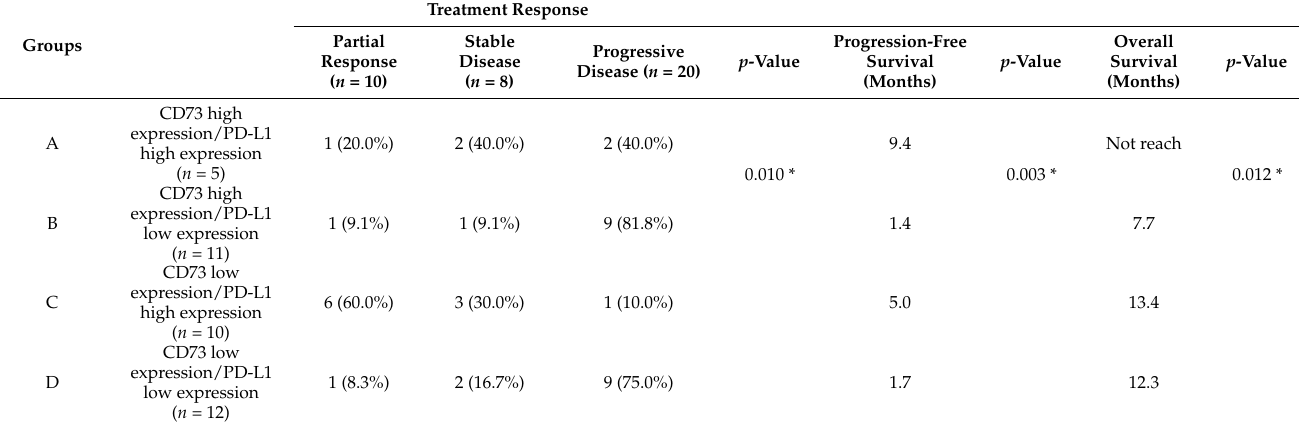
Figure 3. Results of the immunohistochemical analysis of CD73 and programmed death ligand 1 (PD-L1) in the patients with ESCC. Table 5. The correlation of treatment response to immunotherapy and expression of CD73/PD-L1 in 38 ESCC patients who received